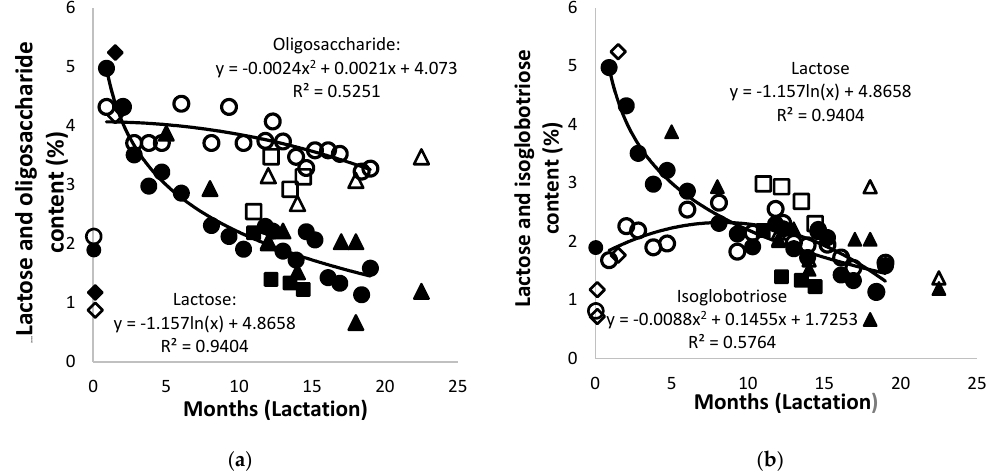
Figure 7. ( a ) Changes of lactose (solid symbols) and oligosaccharides (open symbols) and ( b ) of lactose (solid symbols) and isoglobotriose (open symbols) in the milk of African elephants during lactation (Shorty ( ● ○ ), Bloem ( ♦ ◊ ) Mussina ( ■ □ ), and others ( ▲ Δ )). Trend lines for combined data of all animals were y = − 1.313ln(x) + 5.1479 and R 2 = 0.9146 for lactose, y = 0.003x 2 + 0.1128x + 4.3682 and R 2 = 0.3998 for oligosaccharides, and y = 0.0068x 2 + 0.1292x + 1.7396 and R 2 = 0.2966 for isoglobotriose. The isoglobotriose content increased from 0.8% in colostrum to 2.2% at 12 months of lactation; it